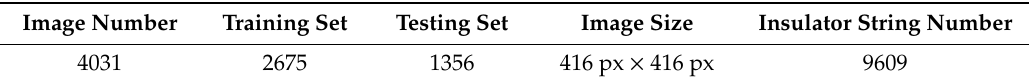
Table 2. The InST_detection dataset.